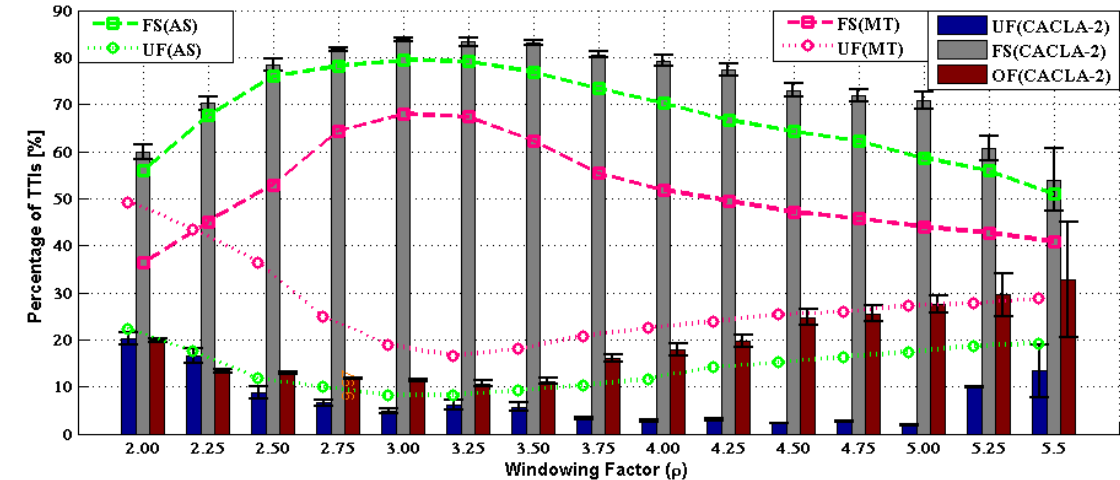
Figure 7. System performance of the proposed CACLA-2 framework and state-of-the-art